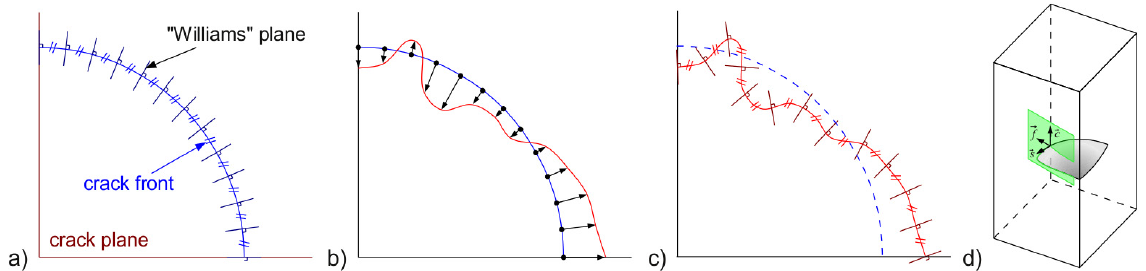
Figure 3: Schematic illustration of the iterative crack front extraction process : an initial crack front position is assumed (a) to build a series of planes which will be used for fitting the Williams series. Once the new position of the front is found (b) (see the text for details) a new series of planes is build (c) ; for non planar cracks, the process can be carried out in 3D (d). Examples of stress intensity profiles obtained along the crack fronts of the propagating cracks can be obtained with this method and used to plot local da/dN=f(DK)